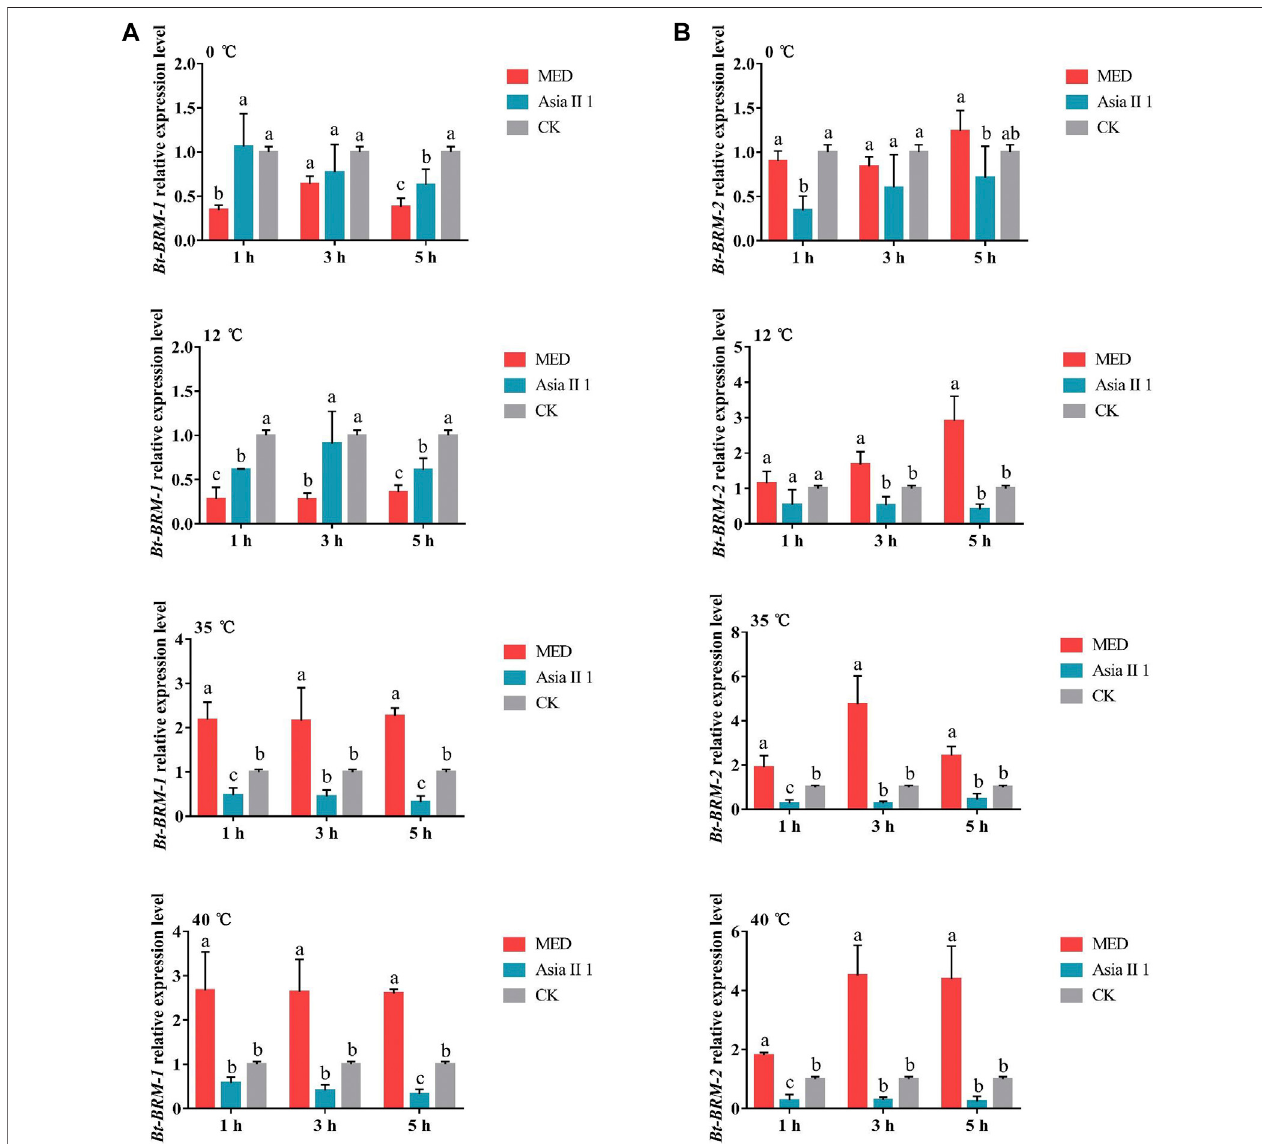
FIGURE6 | Relative expression levels of Bt-BRM-1 (A) and Bt-BRM-2 (B) in MED and Asia II1 after exposuretodifferenttemperatures. Different lowercase letters indicate signi fi cant difference at p < 0.05.